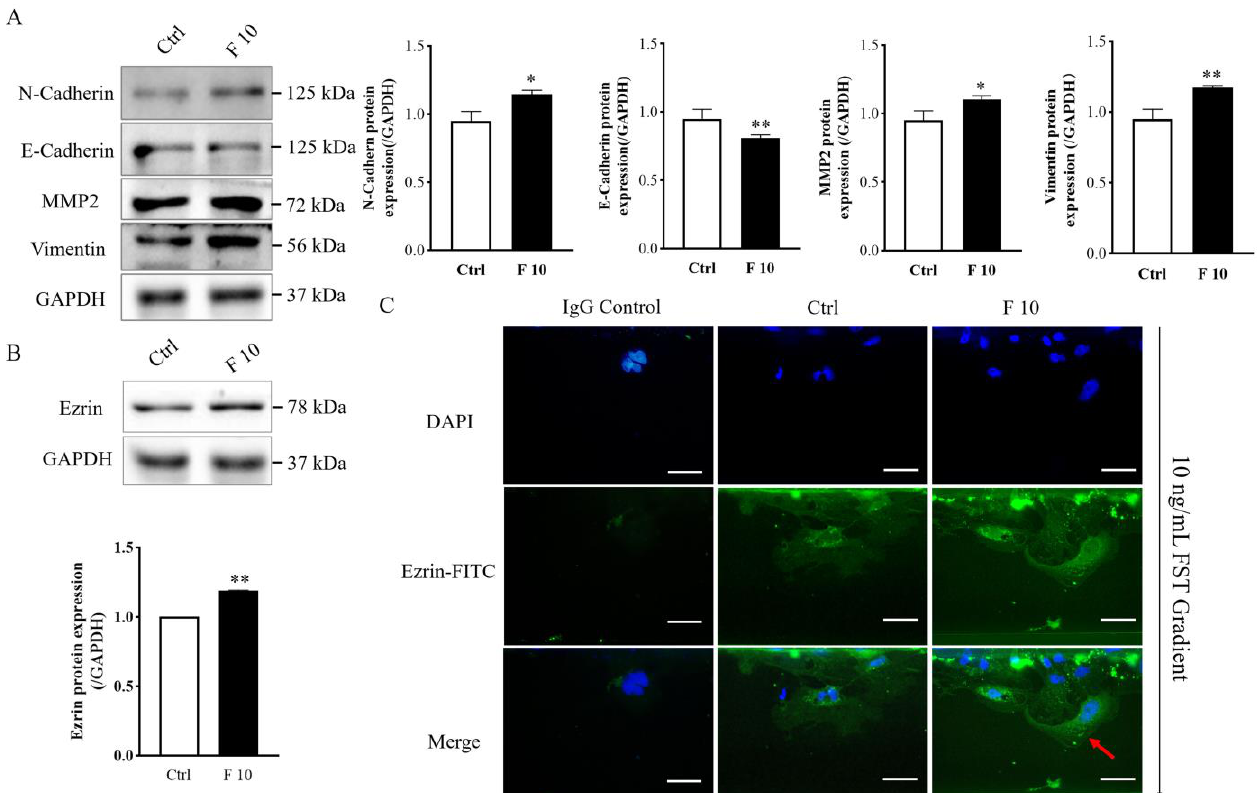
Figure 6. Effects of FST on expression of migration-related protein and polarization of mice trophoblasts. ( A ) Migration-related protein expression was examined by Western blotting in primary cultured trophoblasts treated with 2% FBS culture medium (Ctrl) and 10 ng/mL FST (F10) for 24 h. The graph represents the relative levels of protein expression ( n = 3). The expression levels of protein were normalized against GAPDH expression. ( B ) Ezrin expression in primary cultured trophoblasts of mice were analyzed by Western blotting. The graph represented the relative levels of ezrin protein expression ( n = 3). ( C ) Ezrin distribution in primary cultured trophoblasts of mice were examined by immunofluorescent staining in microfluidic chip. IgG control, trophoblasts were stained with the normal rabbit IgG as isotype IgG control taking the place of anti-Ezrin antibody. Ctrl: trophoblasts that were treated with 2% FBS culture medium were stained with anti-Ezrin antibody. F 10, trophoblasts that were treated with 10 ng/mL FST were stained with anti-Ezrin antibody. Red arrows indicated the typical changes of Ezrin distribution in cells treated by 10 ng/mL FST. Scale bar = 50 μm. * p < 0.05. ** p < 0.01, compared with control.